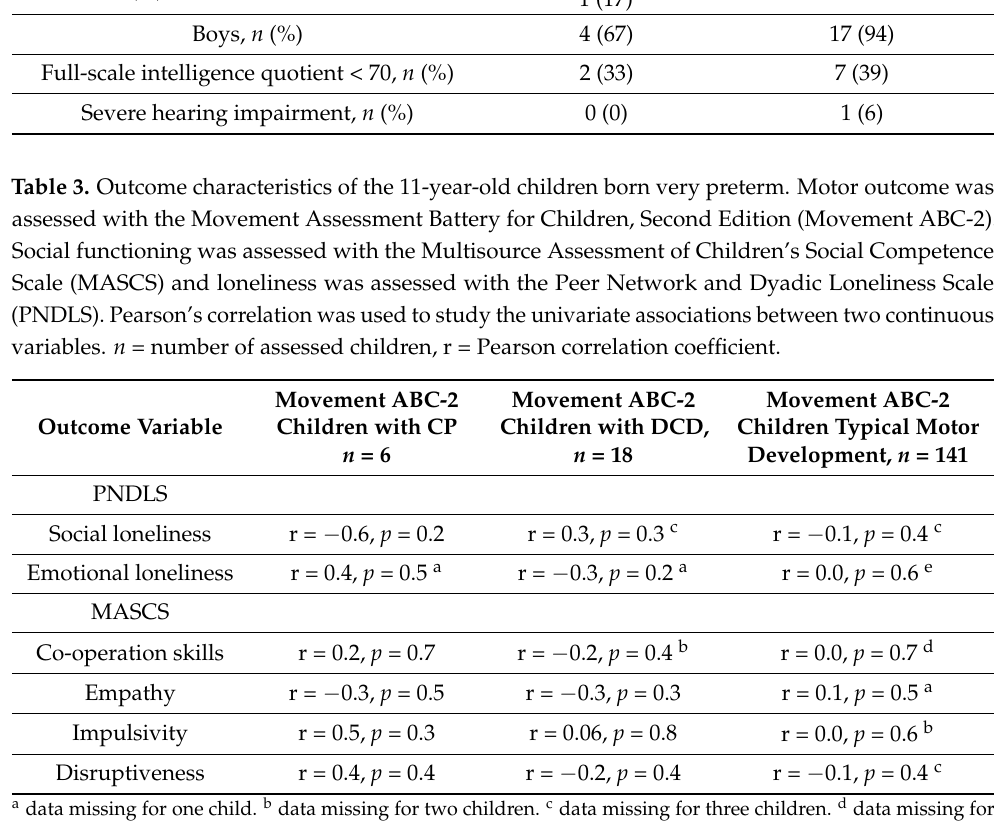
a data missing for one child. b data missing for two children. c data missing for three children. d data missing for four children. e data missing for six